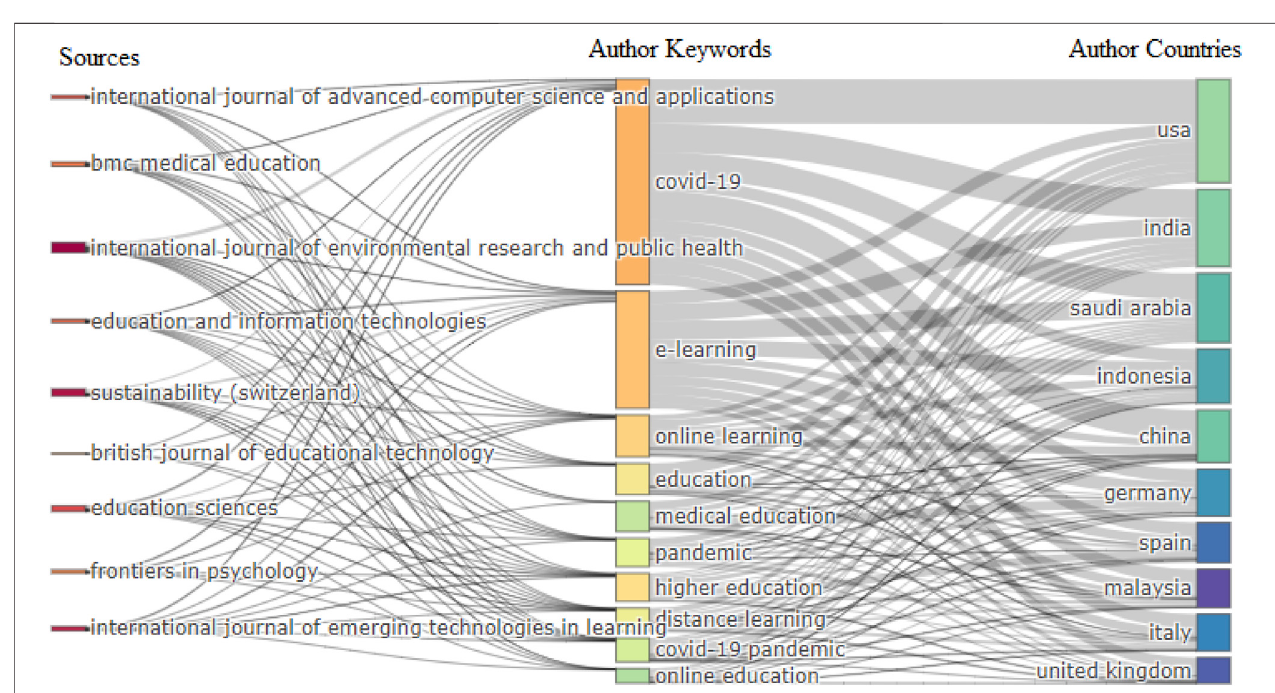
FIGURE 8 | Three- fi elds